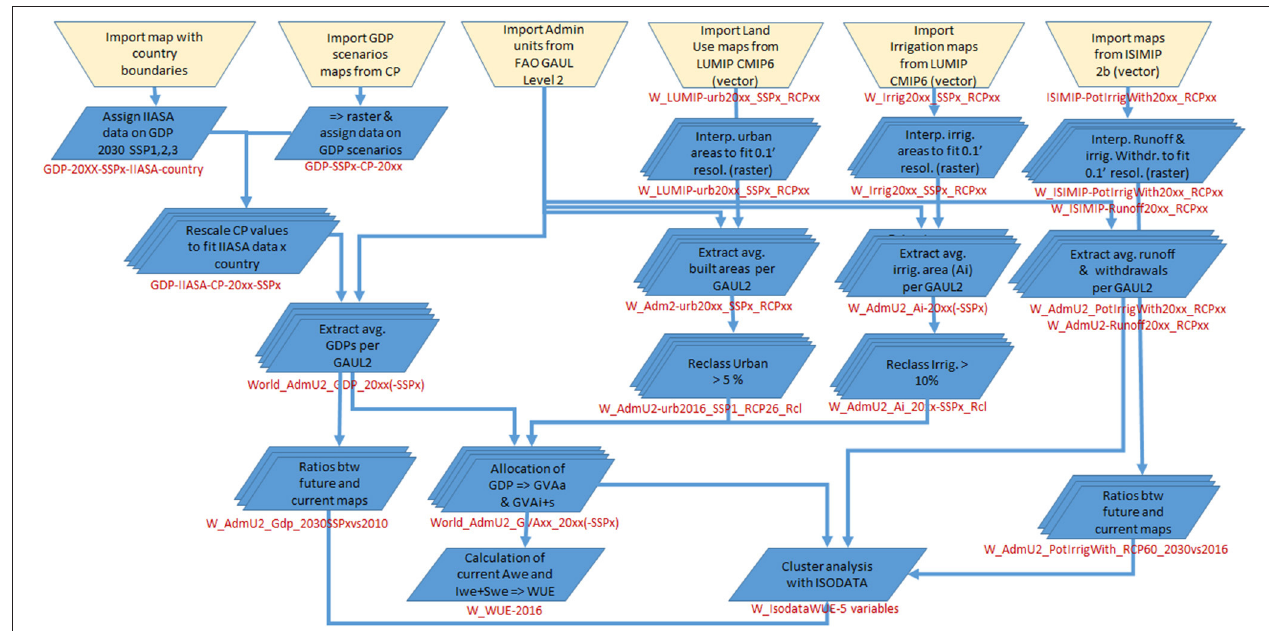
FIGURE 1 | Flow-chart of the proposed approach (file nomenclature in